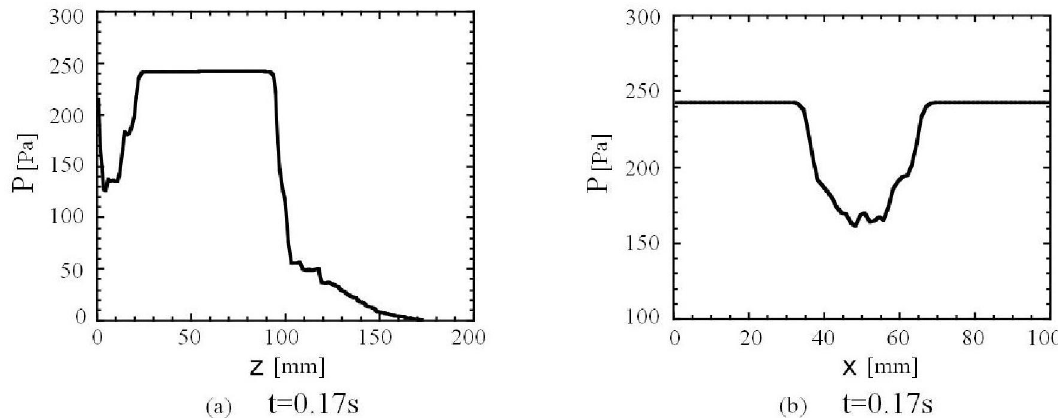
Figure 11. Distributions of air pressure P. ( a ) Vertical distribution at t = 0.2 s and x = 31 mm that is near the edge of hopper outlet and y = 2.5 mm. ( b ) Horizontal distribution at t = 0.2 s and 50 mm height from the bottom of the bin and y = 2.5